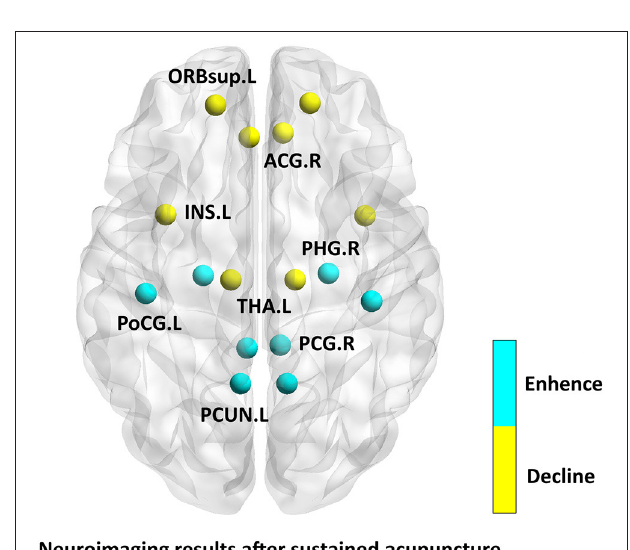
FIGURE 4 | Neuroimaging results after sustained